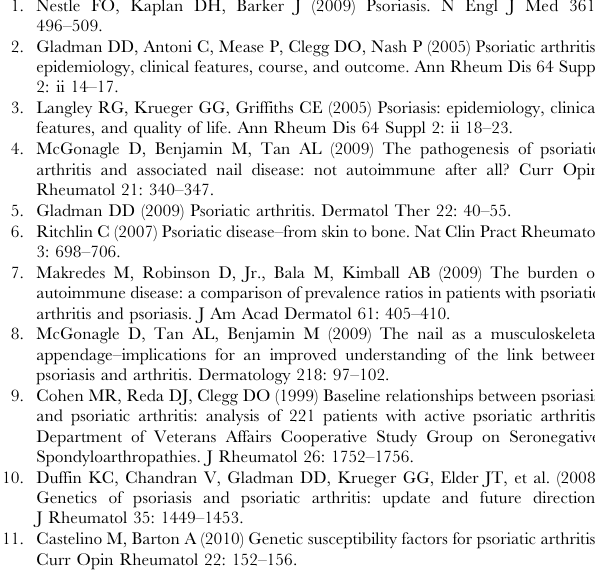
Figure S5 Extended 10-area Linear Psoriasis Area and Severity Index (XL-PASI) combines the PASI and PWESI scoring methods. This measure includes assessment of surface area involved, as well as dimensions for scaling, erythema, thickness and joint involvement for specific areas of psoriatic involvement. As with the PASI, severity indicators range from 0 (none) to 4 (extremely severe). As with the PWESI, body surface area is divided into ten (‘‘X’’) areas and each area is quantified. The scale of the XL-PASI ranges from 0 to